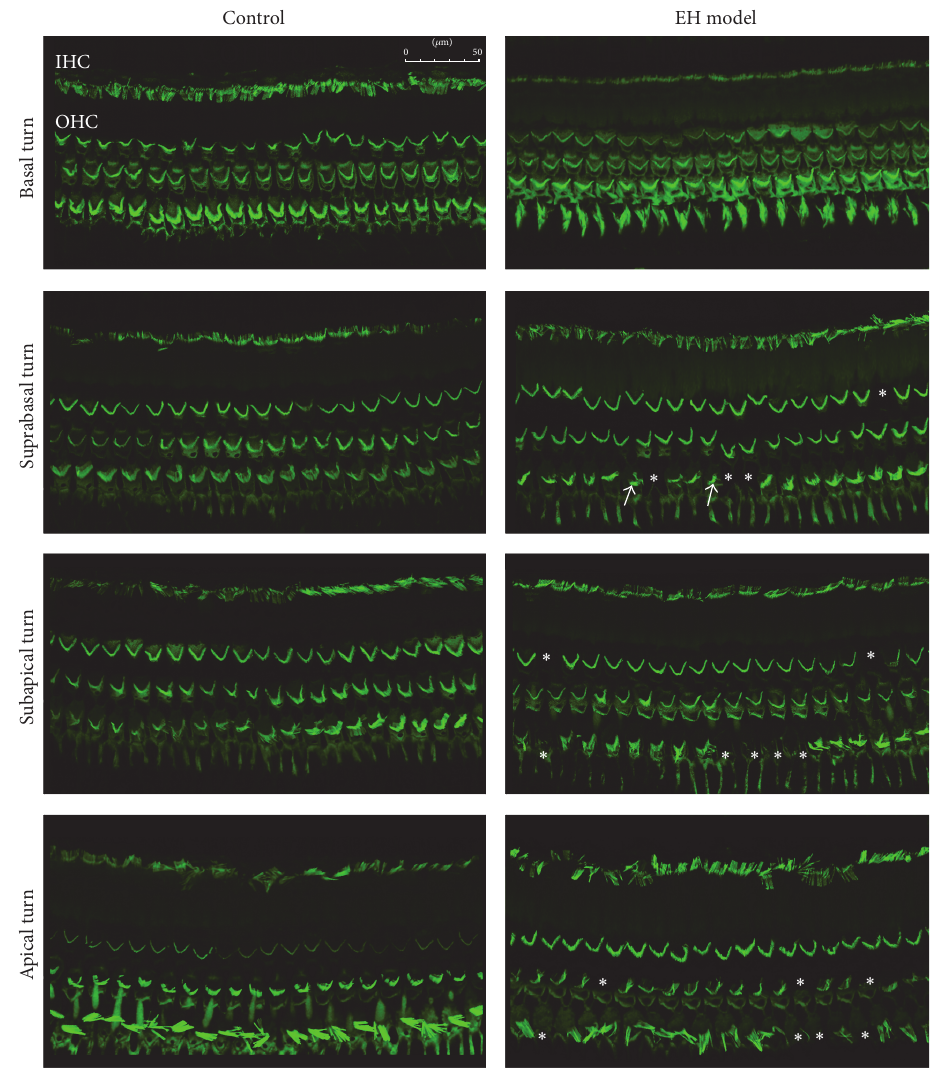
Figure 7: Confocal image of cochlea basilar membrane staining with FITC-conjugated phalloidin in the four turns of control group and EH model group. Accidental loss of stereocilia of outer hair cells (∗) in the suprabasal, subapical, and apical turns was observed. Sporadic collapse and derangement of stereocilia (white arrow) were found in the third row of outer hair cells. Inner hair cells showed